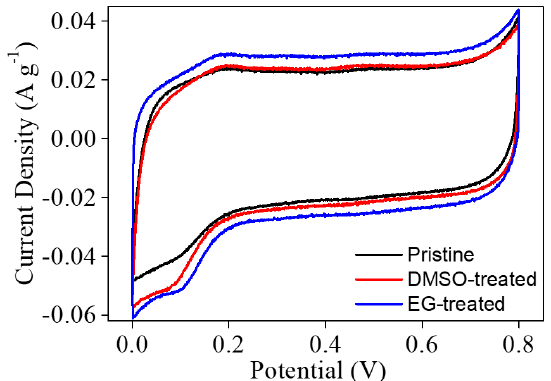
Figure 5. Cyclic voltammetry (CV) graphs of PEDOT:PSS/CNF composite paper samples before and after post-treatment with EG and DMSO at a scan rate of 2 mV s − 1 .